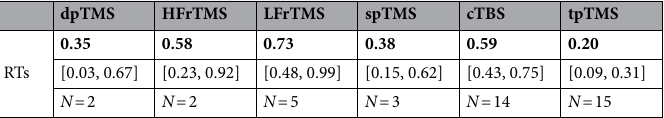
Table 4. Cohen’s d calculated using the stimulation paradigm as